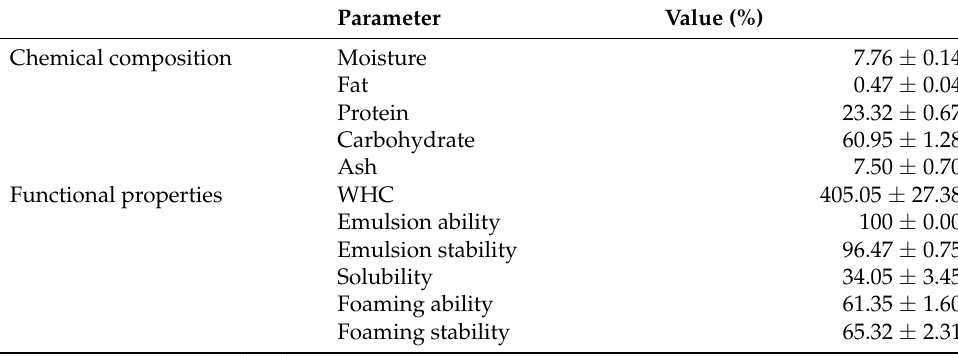
Table 1. Chemical composition and functional properties of SISH.